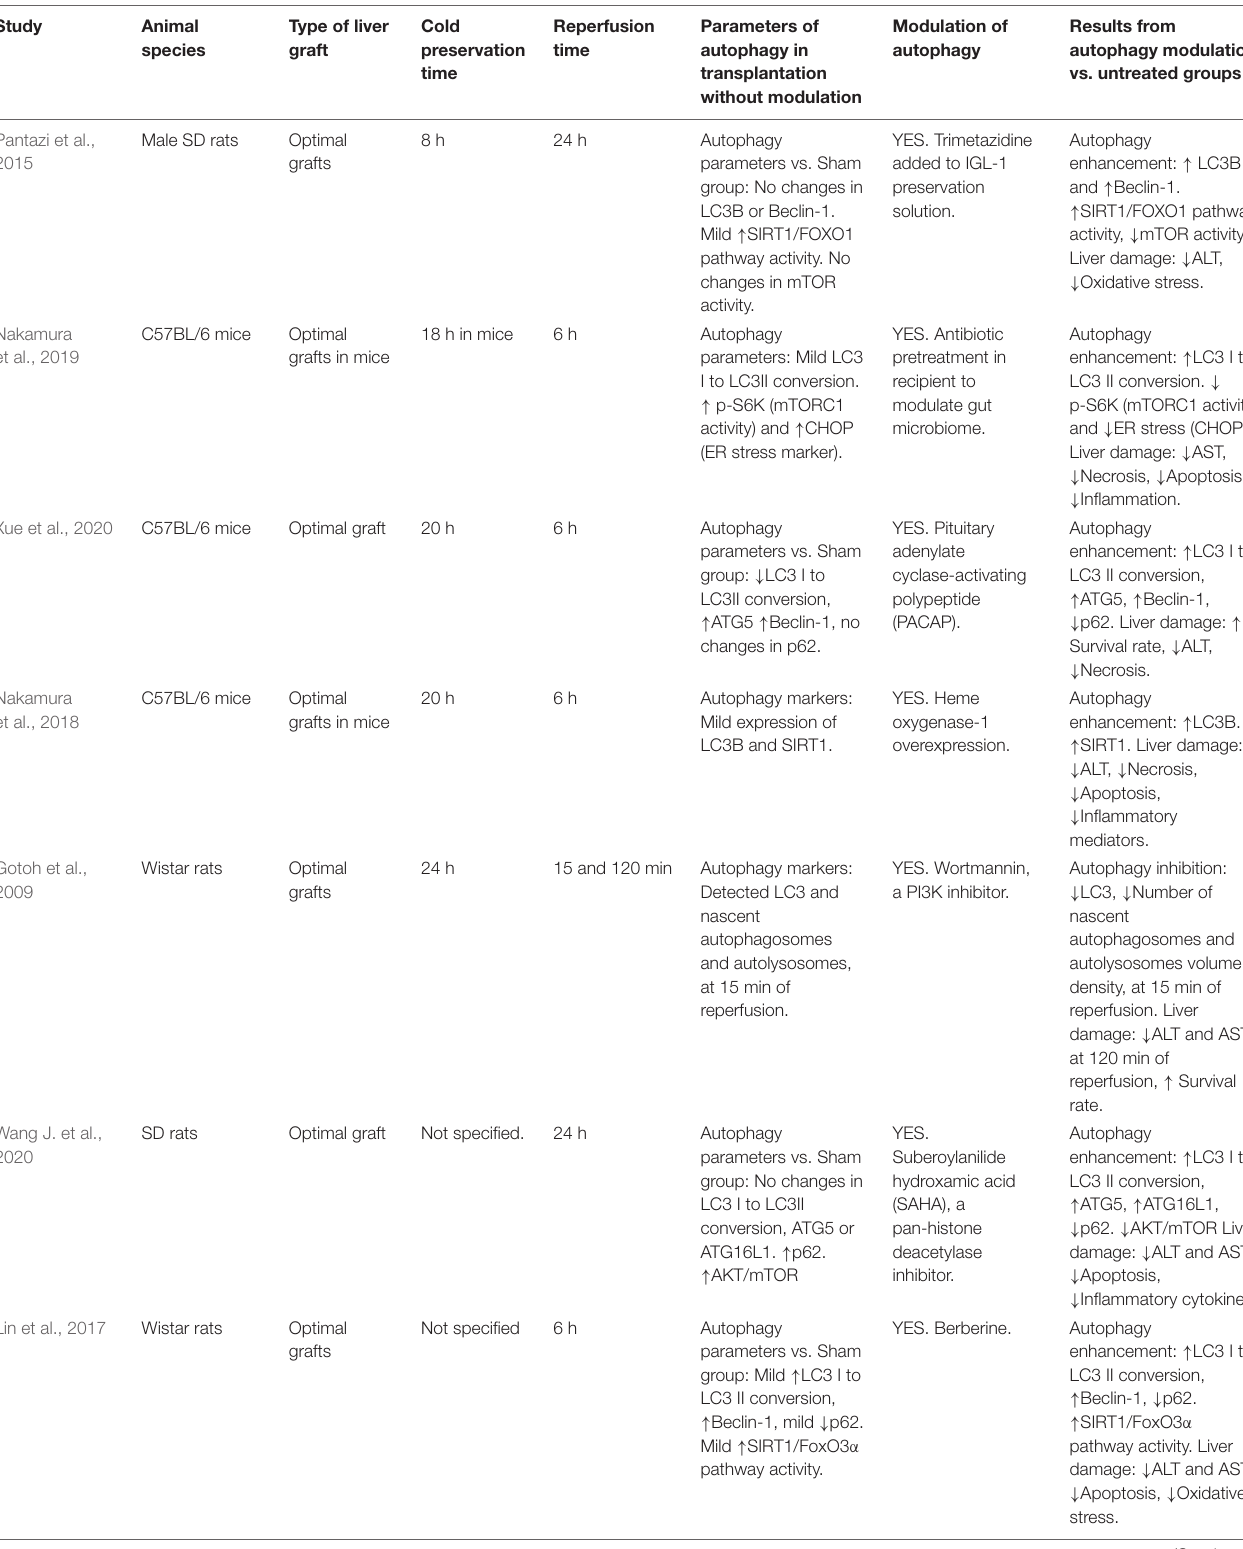
TABLE 2 | Findings about the involvement of autophagy in liver